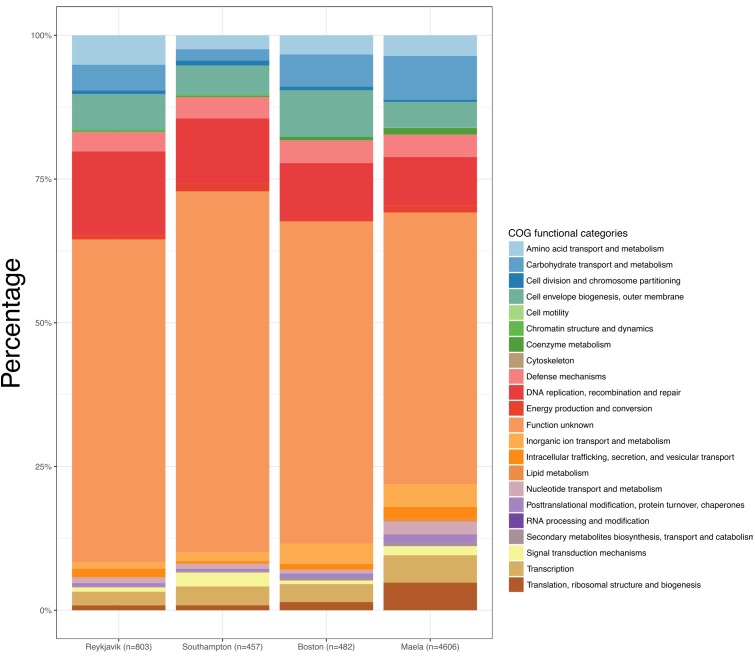
Bar graphs depicting the Clusters of Orthologous Groups (COGs) functional categories of the unique genes in each dataset.